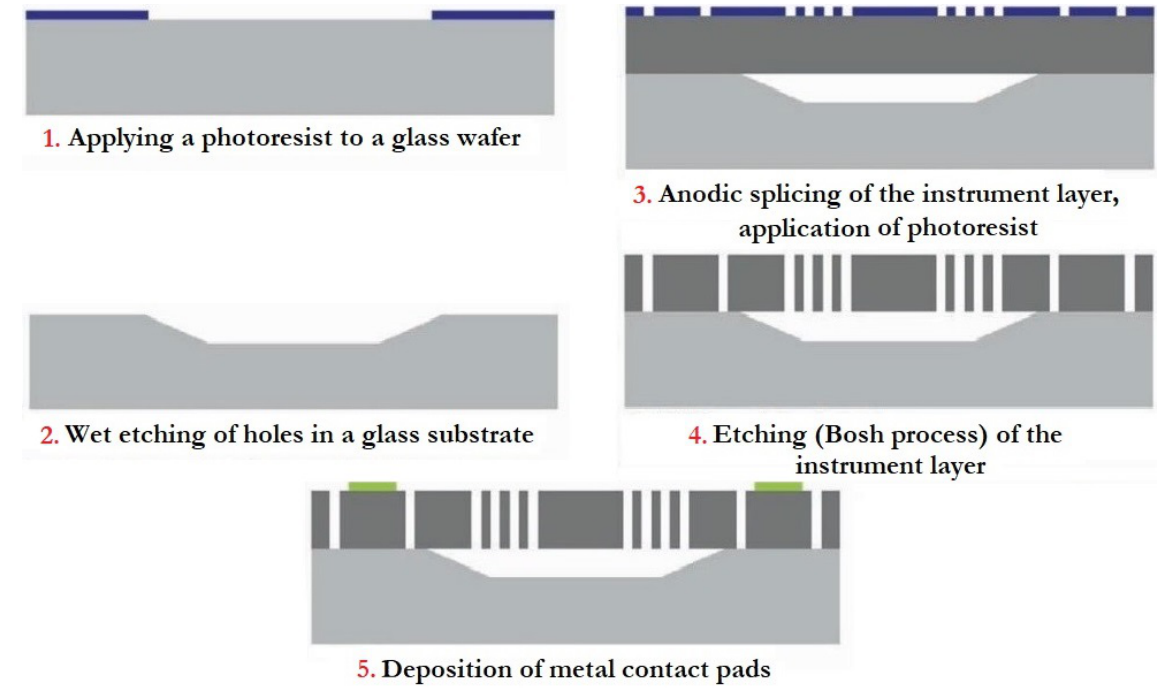
Figure 27. Technological route for the manufacturing of the developed LL-type MEMS gyroscope. All design standards represent restrictions on the geometric dimensions of topological elements. In particular, these are the minimum and maximum allowable dimensions, the minimum allowable gaps between elements, area restrictions, etc. The topology of technologically predefined elements is fixed and cannot be changed by the developer. The process parameters are presented in Table 7. Table 7. The main parameters of the manufacturing